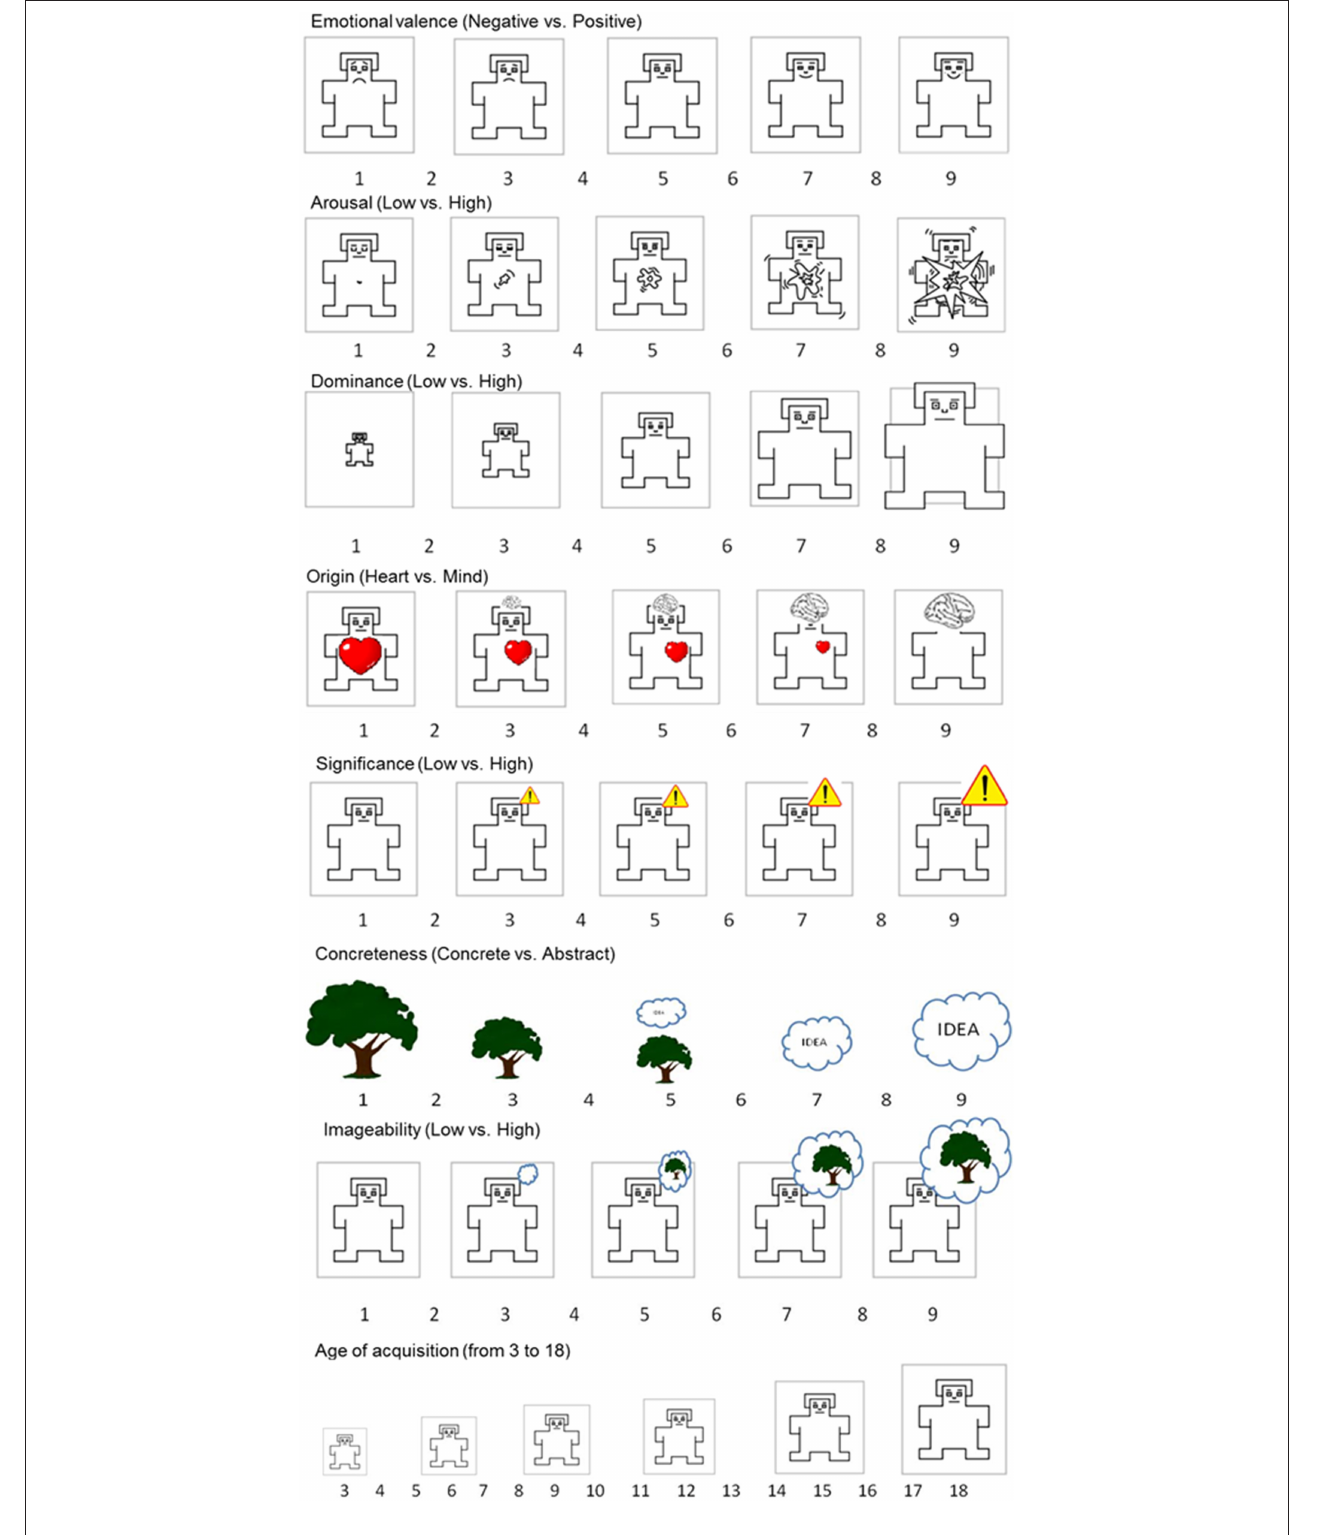
FIGURE 1 | Self-Assessment Manikin